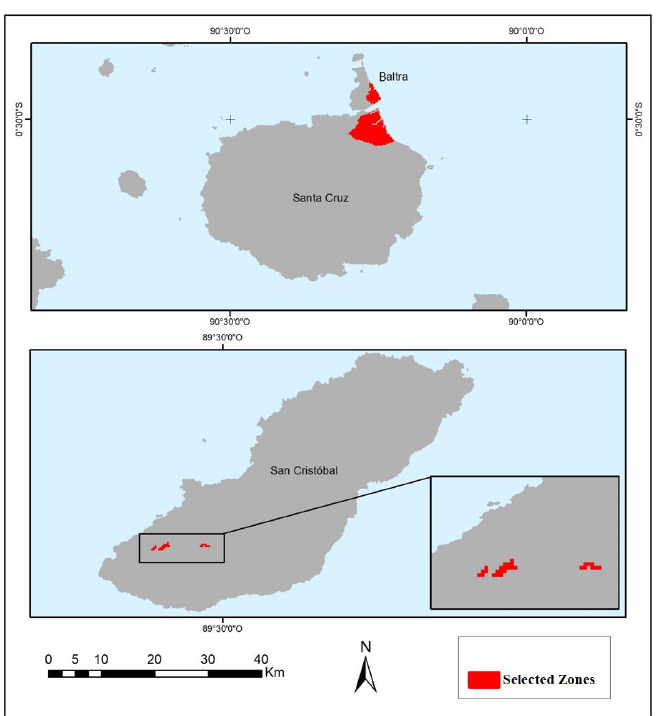
Figure 5. Suitable locations for wind farm projects.